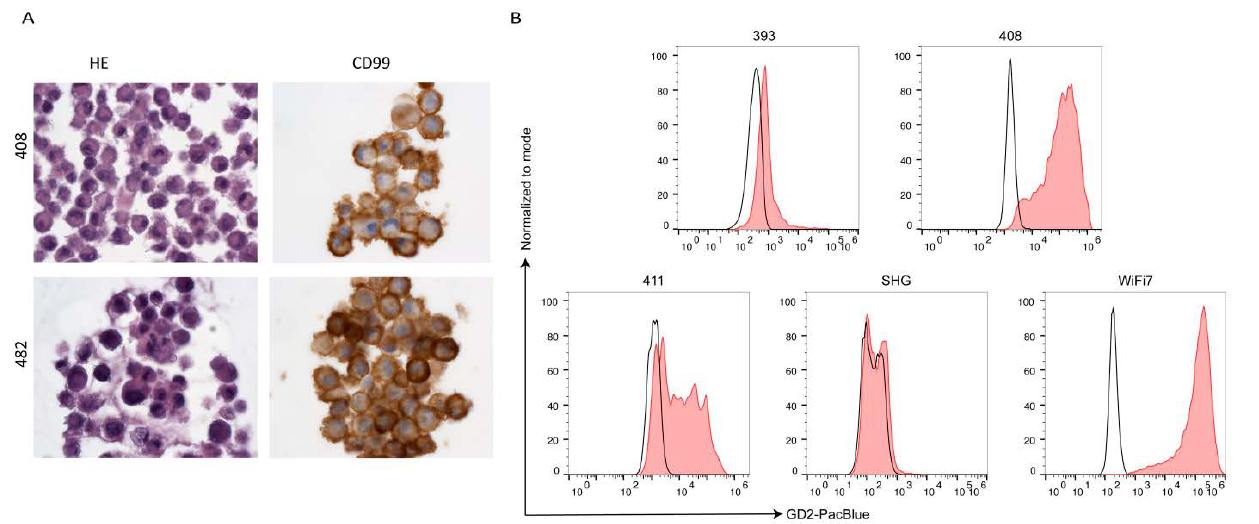
Figure 4. Some ES express high amounts of GD2. ( A ). Validation of ES primary cells. Primary tumor cells were embedded in paraffin and stained with hematoxylin eosin (HE) or analyzed by IHC with a CD99 antibody. Sample no. 408 was isolated from a metastasis in the spine and sample no. 482 from an intracranial metastasis of the same patient. Magnification 630X. ( B ). Expression of GD2 in ES. Primary ES tumor cells were analyzed by flow cytometry with an anti-GD2 antibody. Unstained samples were used as negative controls (black histogram).